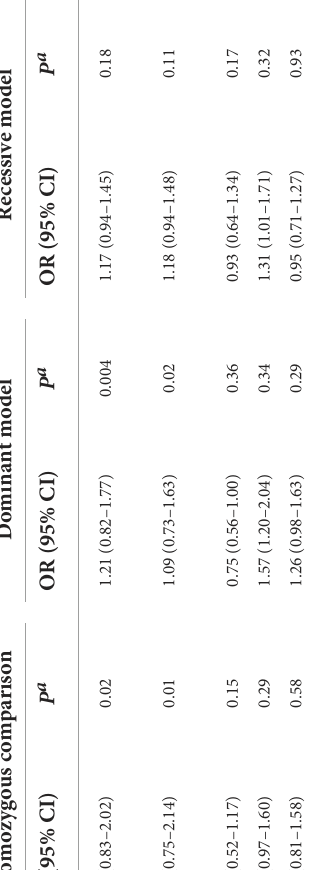
A reverse outcome of the GABRA1 rs2279020 polymorphism with epilepsy risk was observed when the study by Balan et al. was excluded from the